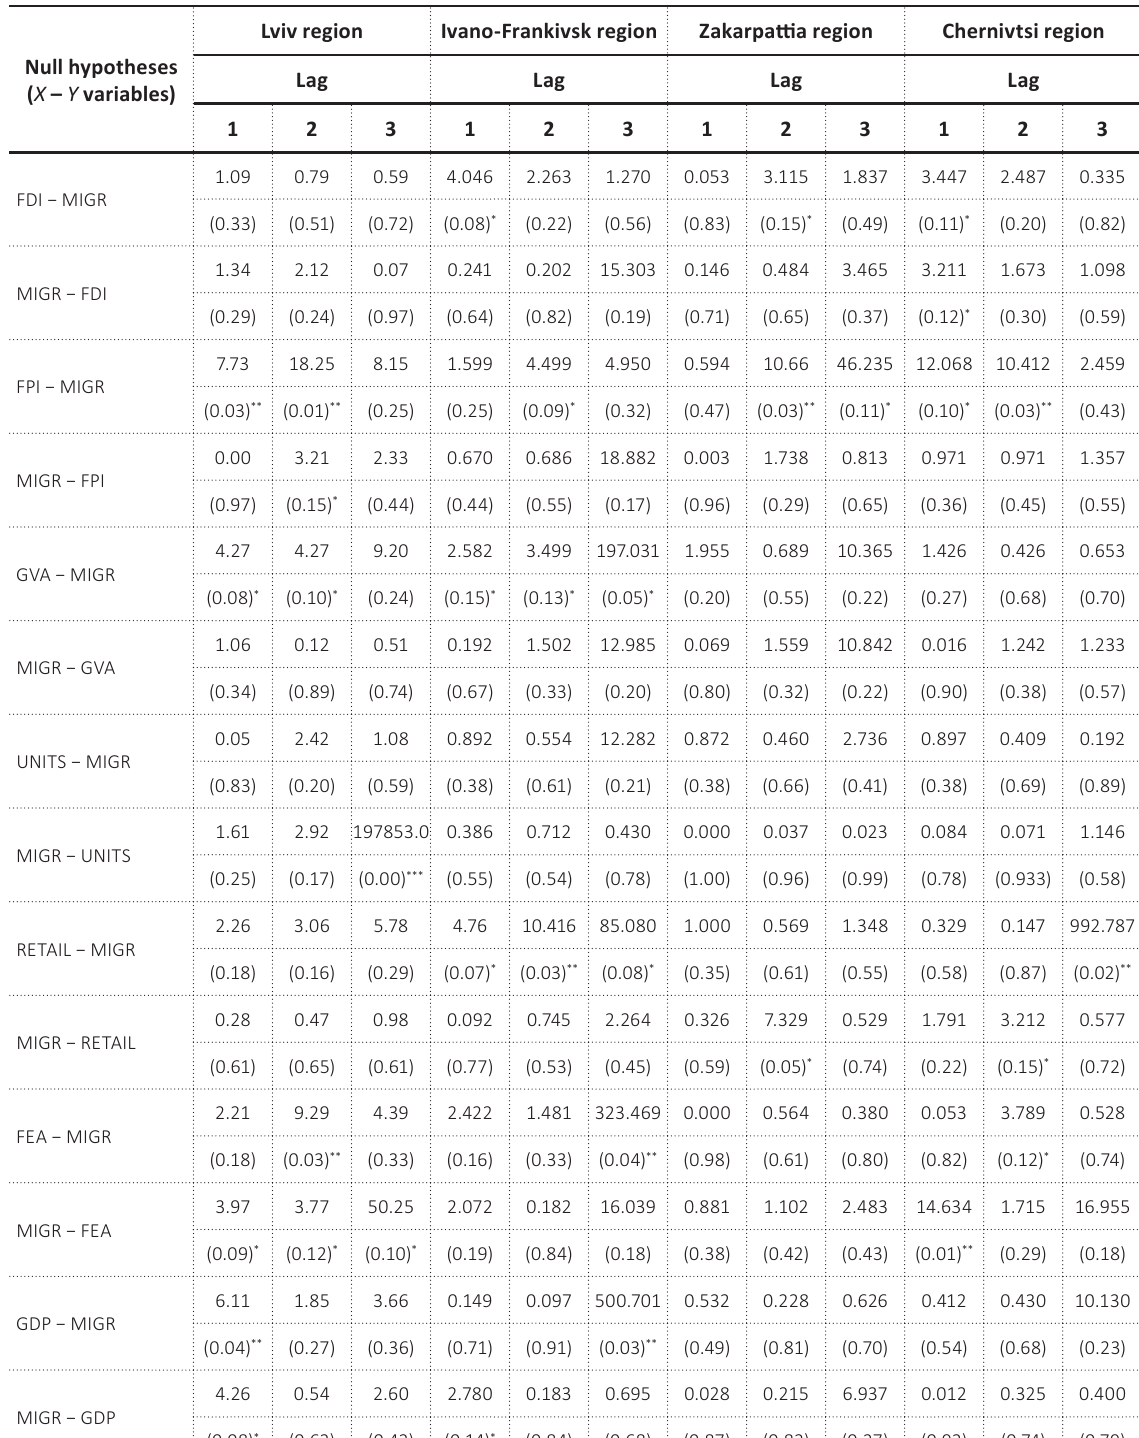
Table A2. Granger causality interaction between population migration and economic development of the Carpathian Region,